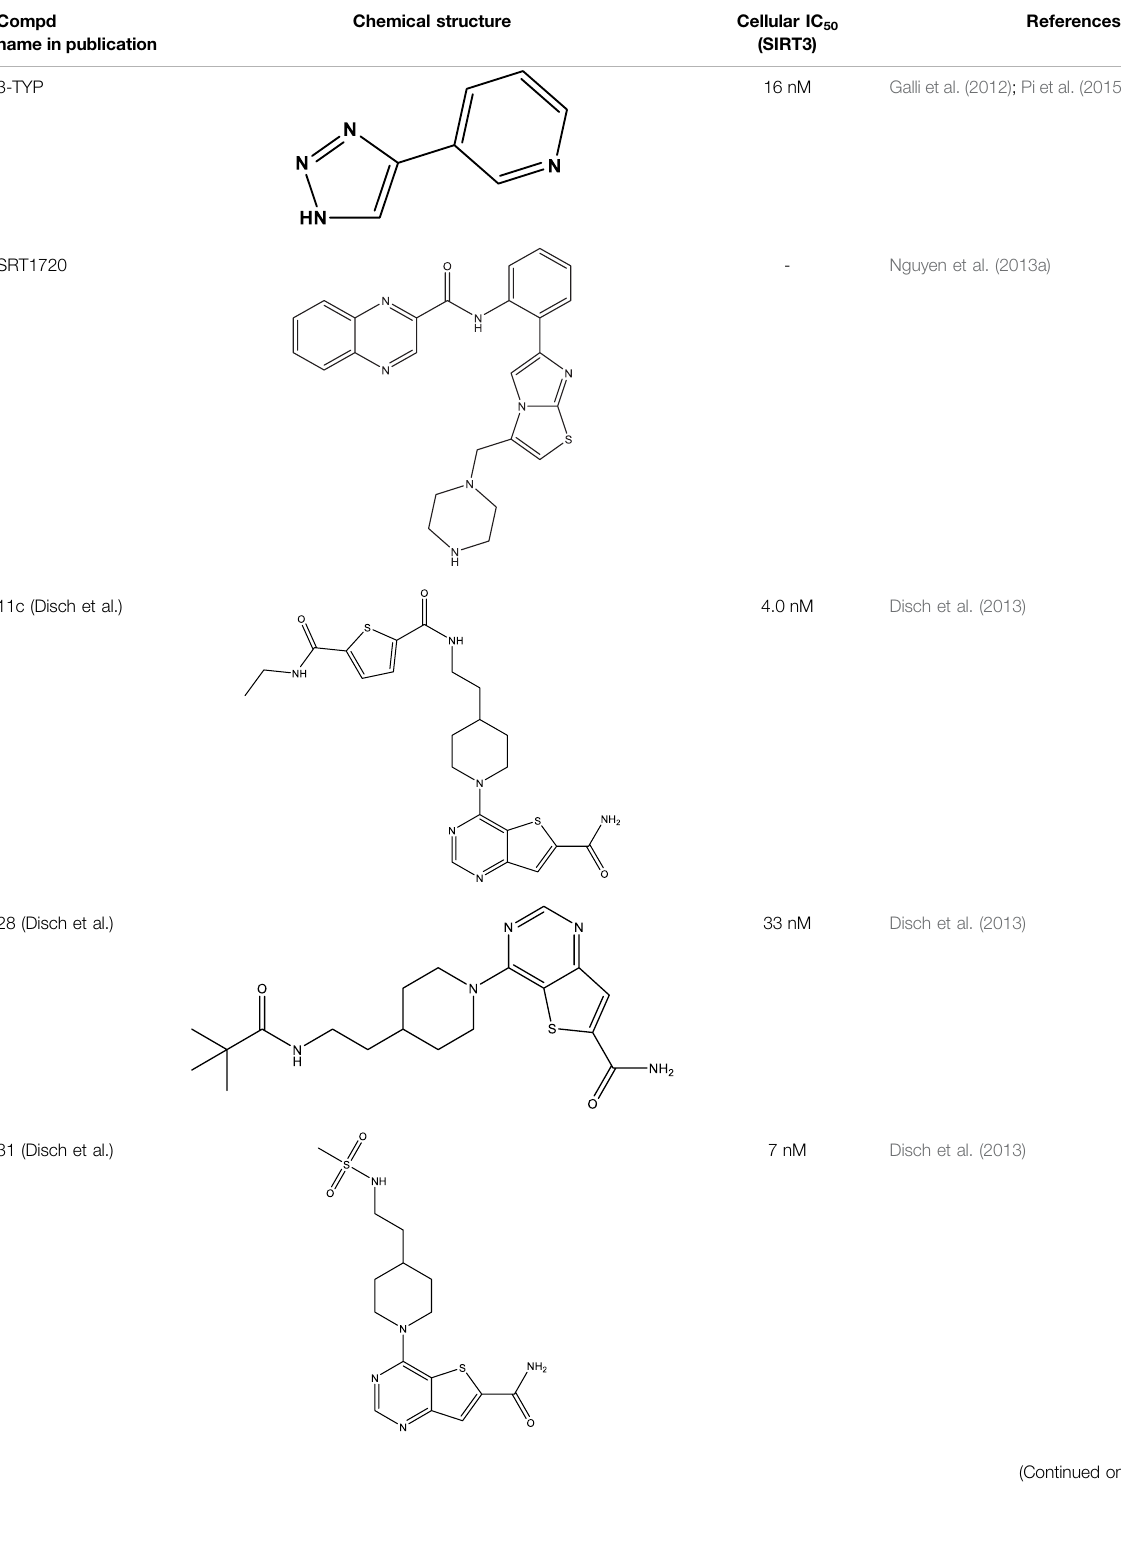
TABLE 3 | Inhibitor of